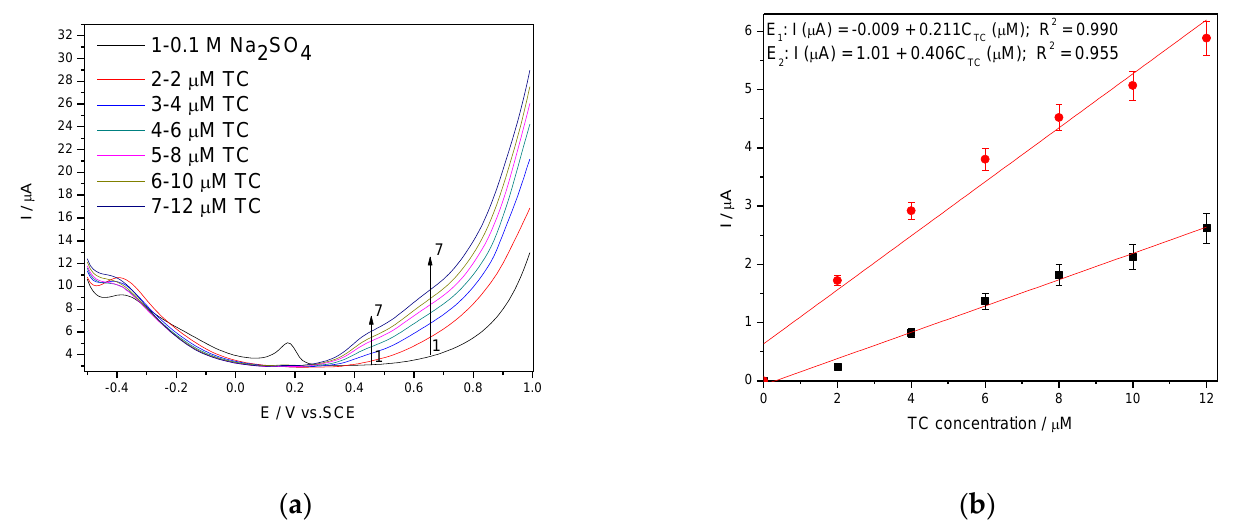
Figure 9. ( a ) DPVs recorded at the Ag/GO/BDD in 0.1 M Na 2 SO 4 supporting electrolyte and in the presence of various TC concentrations: 2-10 µM TC; step potential (SP) 10 mV; modulation amplitude (MA) 100 mV; potential range: − 0.500 to +1.00 V/SCE; ( b ) Calibration plots of the currents recorded at E 1 = +0.433 V/SCE and E 2 = +0.65 V/SCE versus TC concen- trations.